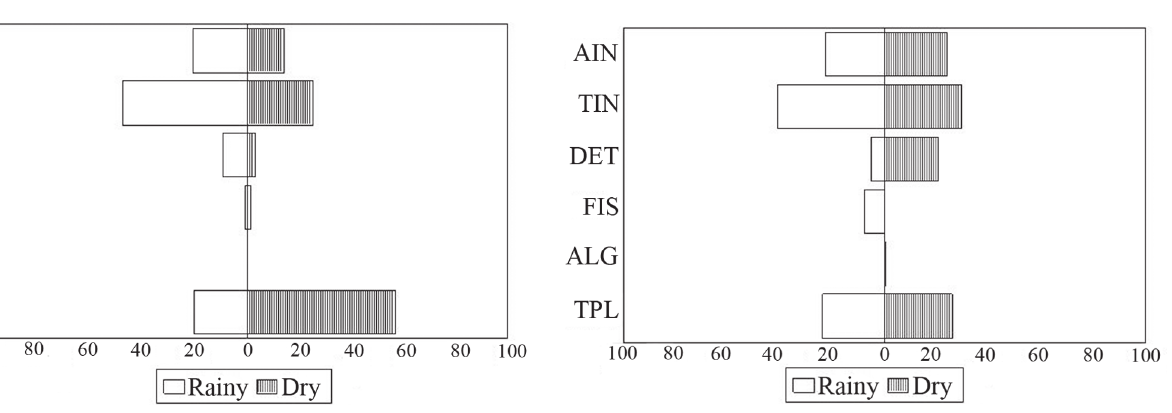
Fig. 5. Percentage composition of food resources consumed by fish species of Itiz stream, Ivaí River basin, Paraná State, Brazil, at site 2 in each hydrological period. AIN = aquatic invertebrates; TIN = terrestrial invertebrates; DET = detritus; FIS = fish; ALG = algae; TPL = terrestrial plants.